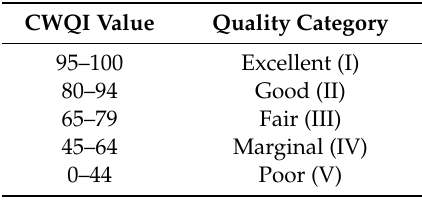
Table 5. Water quality category according to the Canadian Council of Ministers of the Environment Water Quality Index